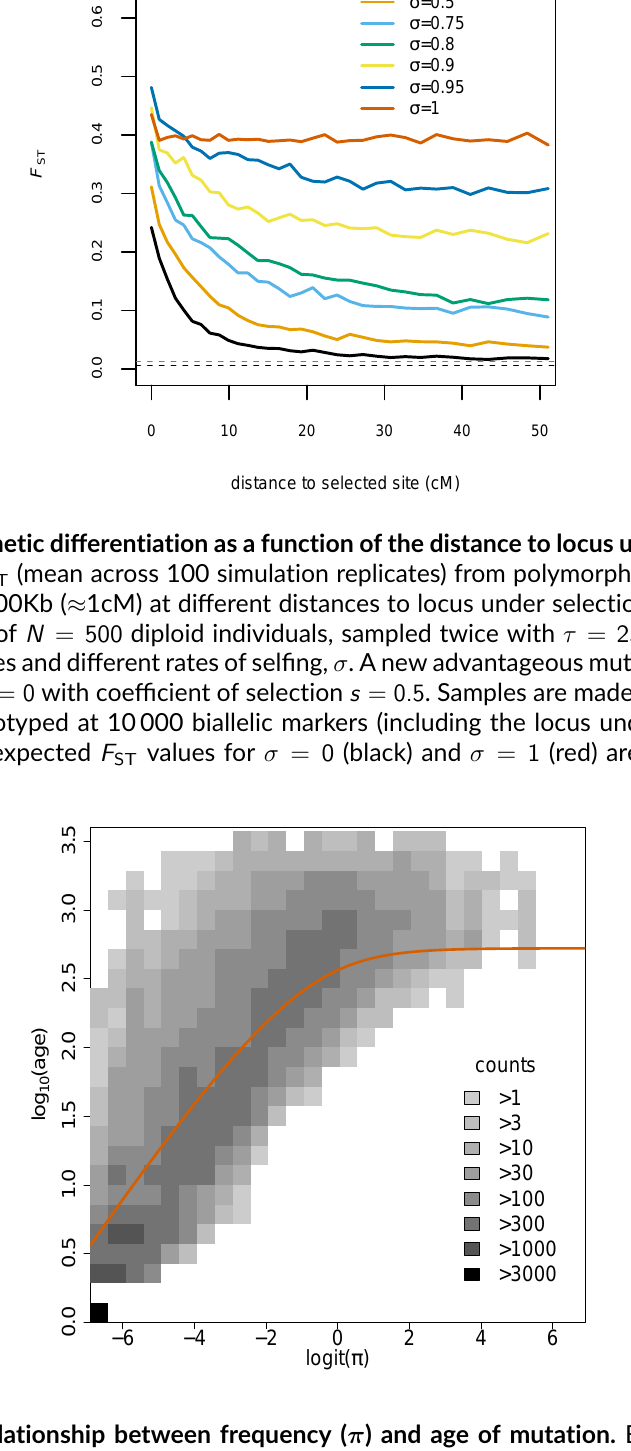
is shown with an (cid:16)